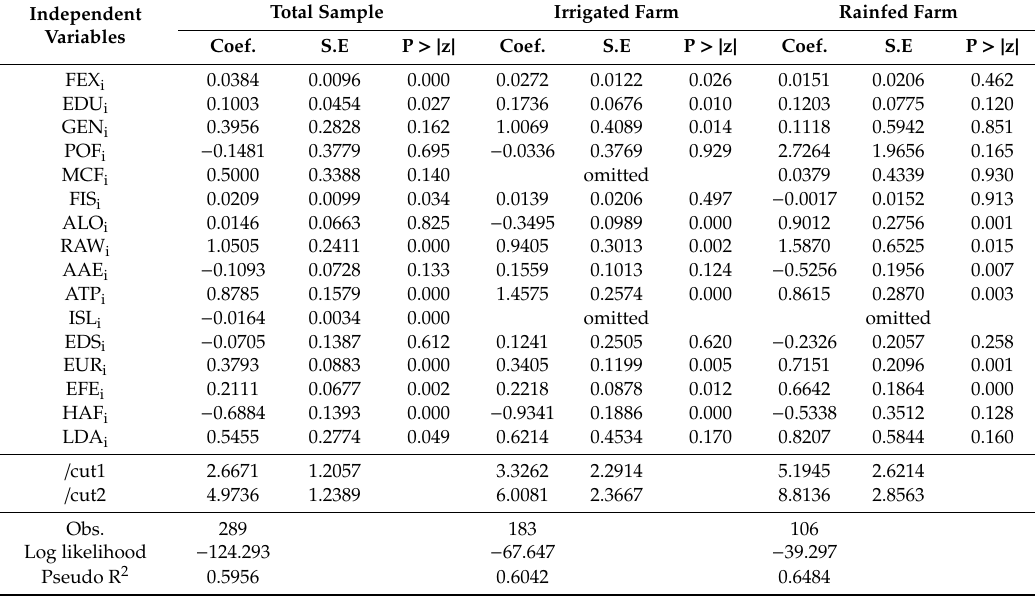
Table 6. Ordered probit model result for all sample households: Dependent variable: Farmers’ perception (1 = Low consistency of perception, 2 = Medium consistency of perception, 3 = High consistency of